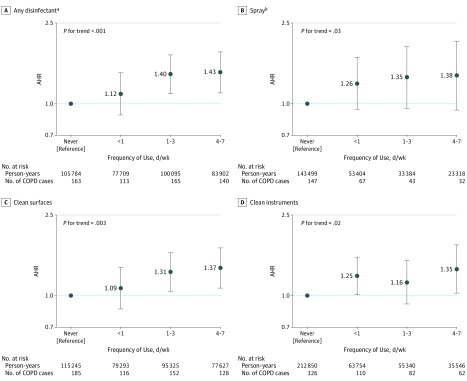
Prospective Association Between Self-reported Frequency of Cleaning/Disinfection Tasks and Chronic Obstructive Pulmonary Disease (COPD) Incidence Among US Female NursesOccupational exposure was evaluated as the highest exposure level at any of the questionnaire cycles before time of diagnosis. The follow-up periods were 2009 to 2015 for job type and use of disinfectants and 2011 to 2015 for use of sprays. Multivariable models were adjusted for age, smoking status and pack-years (continuous), race, ethnicity, and body mass index. Observations with missing values for pack-years of smoking (<0.5%) were excluded from analyses. Observations with missing values for body mass index (3.8%) were included in the model as a “missing” category. Error bars indicate 95% CIs. Adjusted hazard ratios (AHRs) with 95% CIs are shown for type of disinfectant (A and B) and specific use of disinfectant (C and D).aUse of a disinfectant to clean surfaces or instruments.bUse of sprays for patient care, instrument cleaning or disinfection, surface cleaning or disinfection, air refreshing, or other.